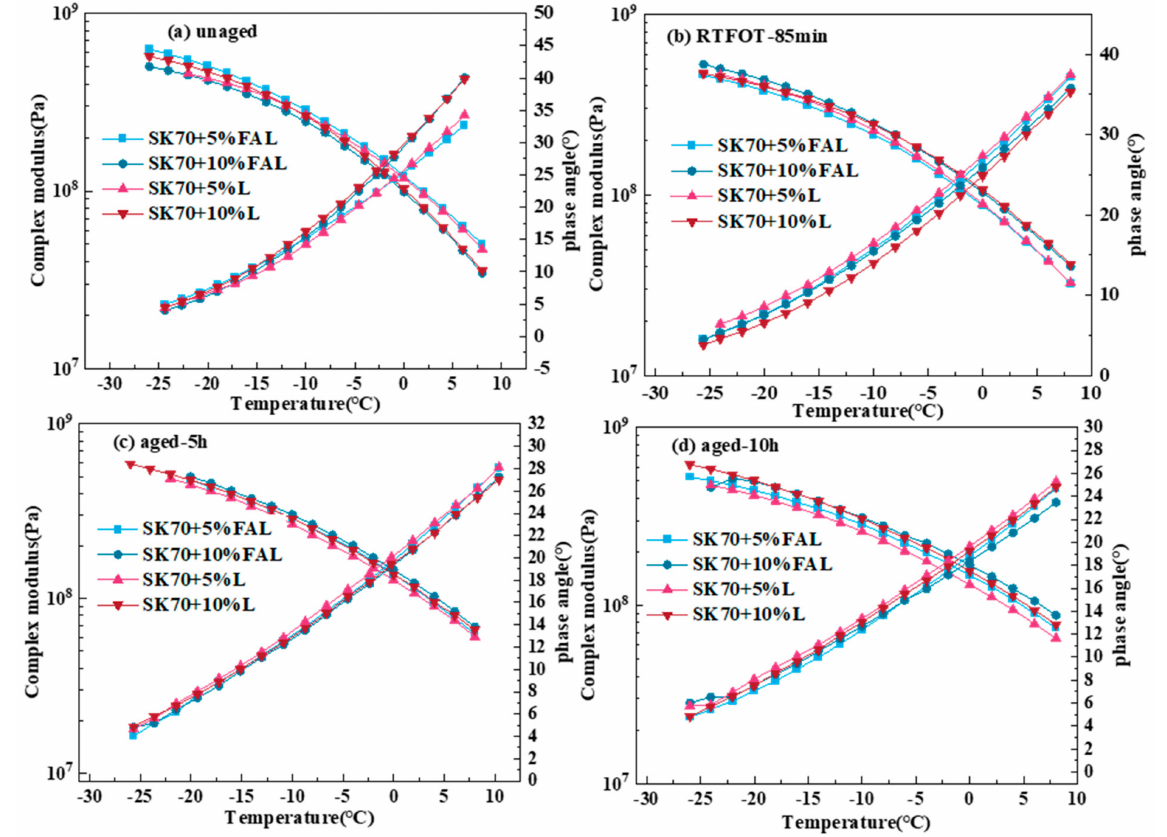
Figure 10. Curves of complex shear modulus G* and phase angle δ with temperatures for each asphalt specimen during different aging